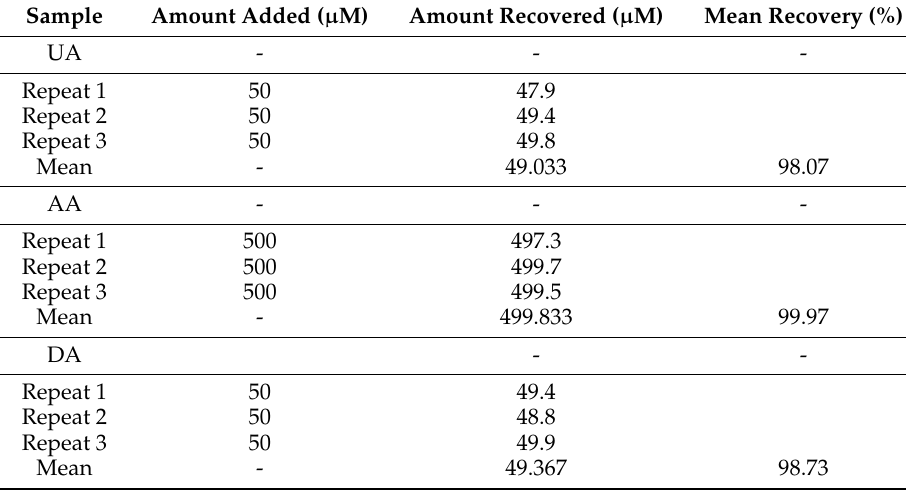
Table 3. Recovery of UA, AA and DA from ternary mixtures in